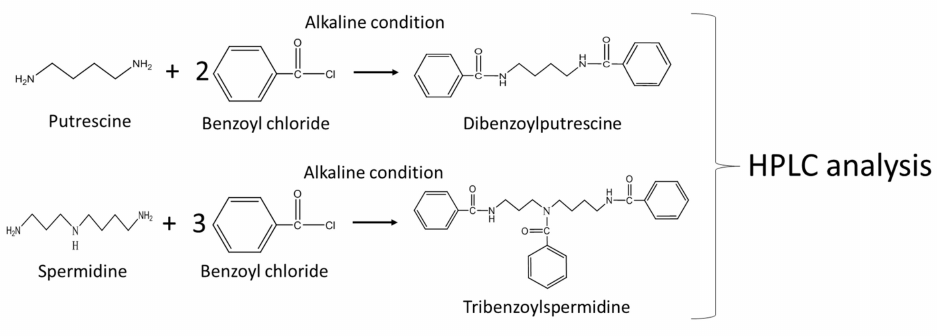
Figure 2. Scheme of derivatization of